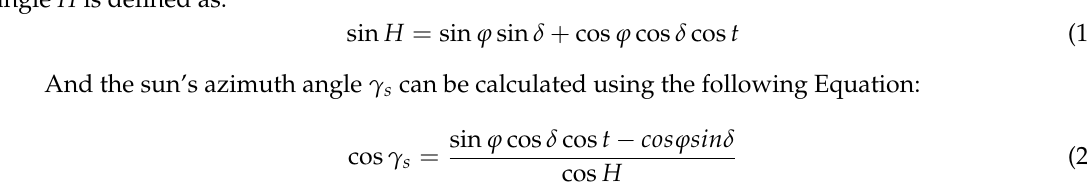
Figure 2. Taking Changzhou city, China (32 ◦ N, 120 ◦ E) as the case, the corresponding solar elevation angle, azimuth angle and illumination intensity are shown in Table 2